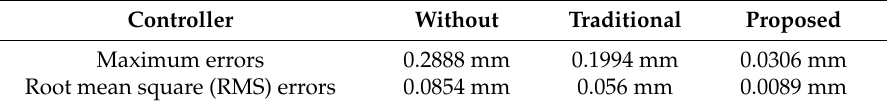
Figure 21. Frequency characteristics with proposed synchronization controller. ( a ) Magnitude frequency characteristics; ( b ) Phase frequency characteristics.